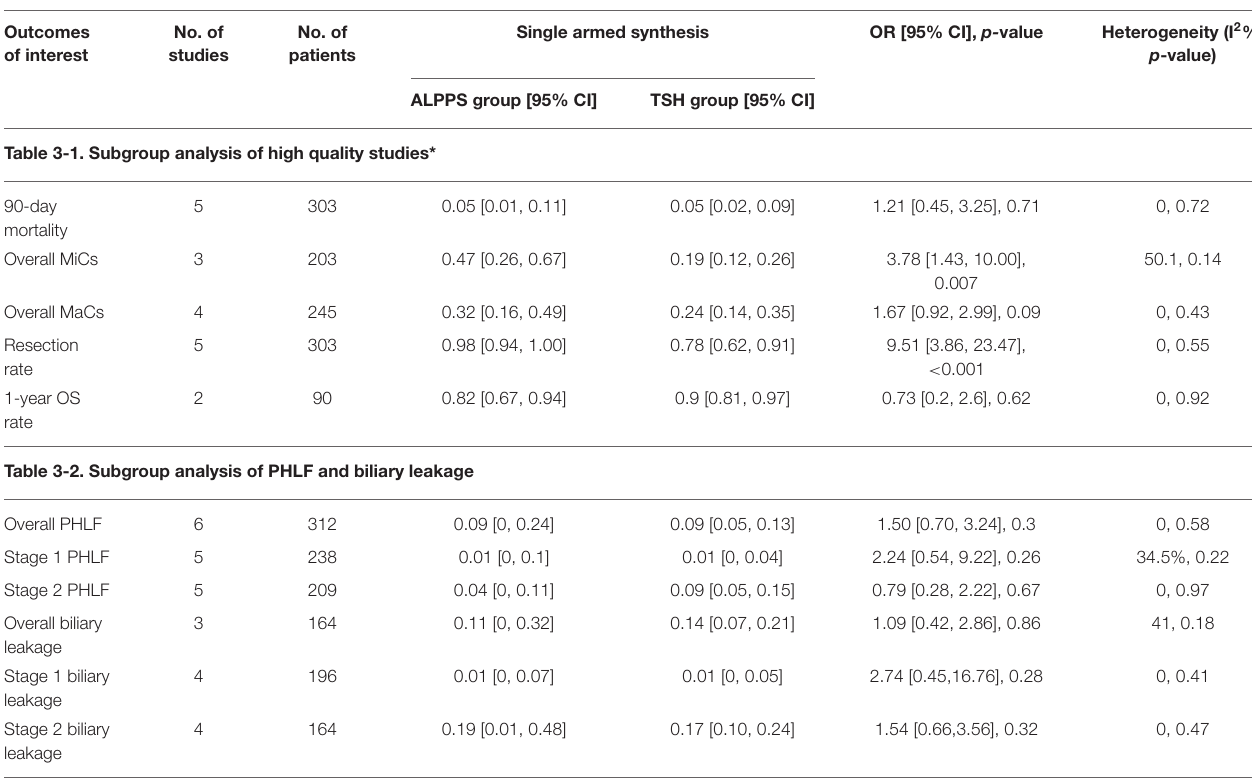
TABLE 3 | Results of subgroup analyses.